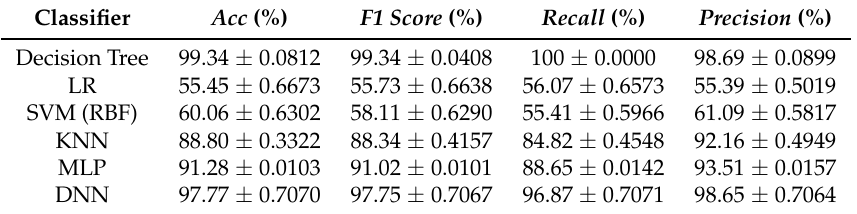
Table 7. Results comparison considering accuracy ( Acc ), F1 score , recall , and precision as evaluation metrics.